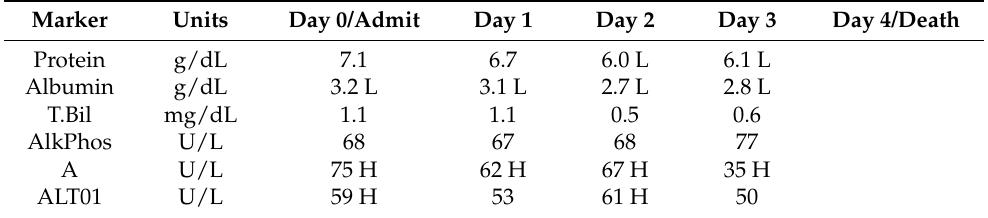
Table 1. Liver function profile.